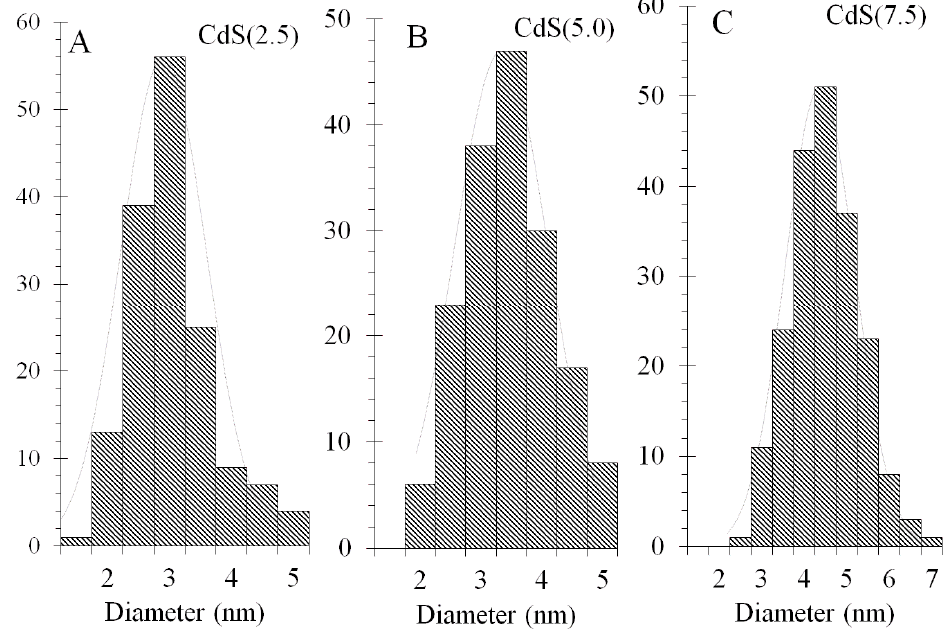
Figure 4. Histograms of different nanocrystals located in TEM analysis for each solution of CdS nanoparticles, for CdS(2.5) ( A ), for CdS(5.0) ( B ), and for CdS(7.5) ( C ).